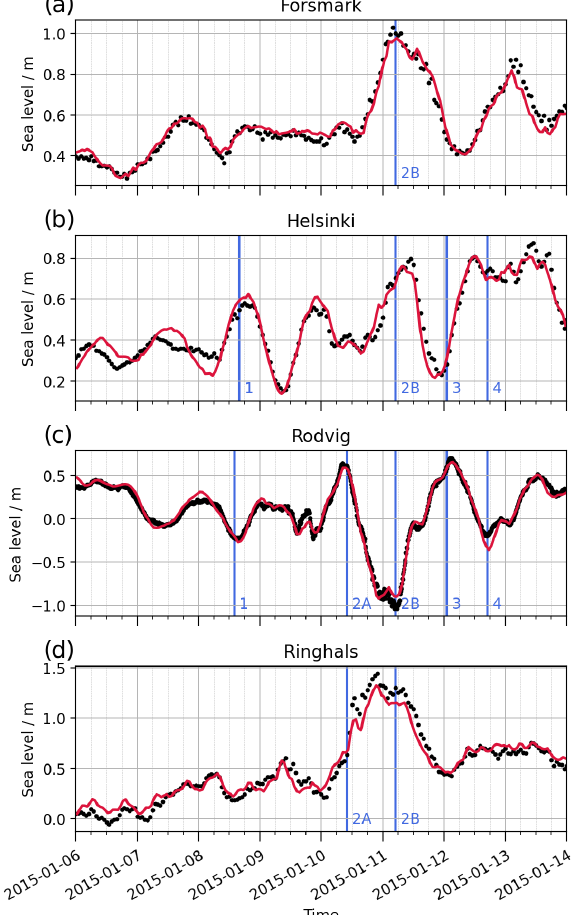
Figure 13. Time series of sea levels at selected locations during the Elon and Felix storms. The red line denotes the model, and the black dots are the observations. The blue vertical lines indicate events dis- cussed in the text. The model data have been bias-corrected for vi- sual comparison.